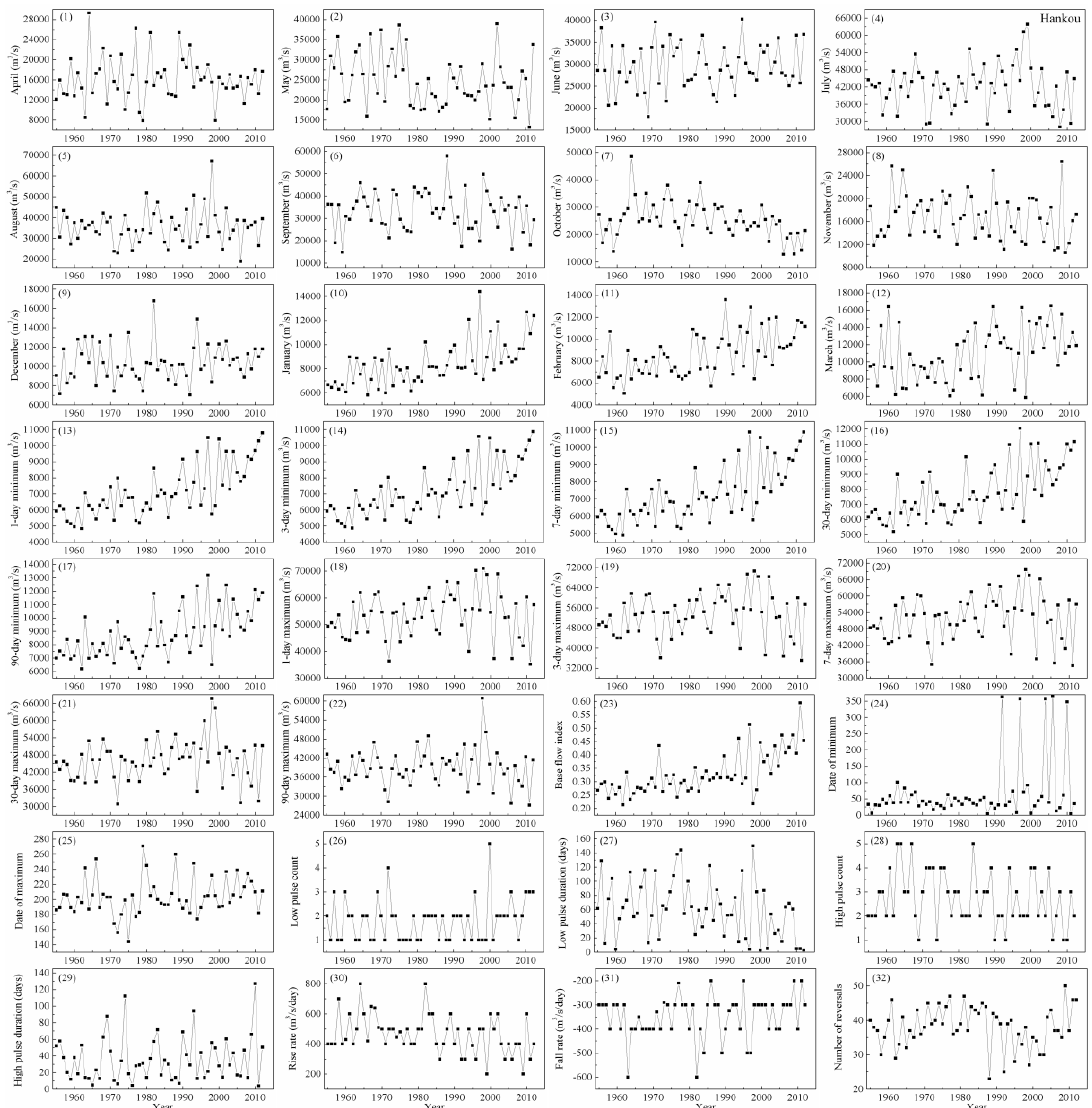
Figure 9. IHA series of the Hankou station.